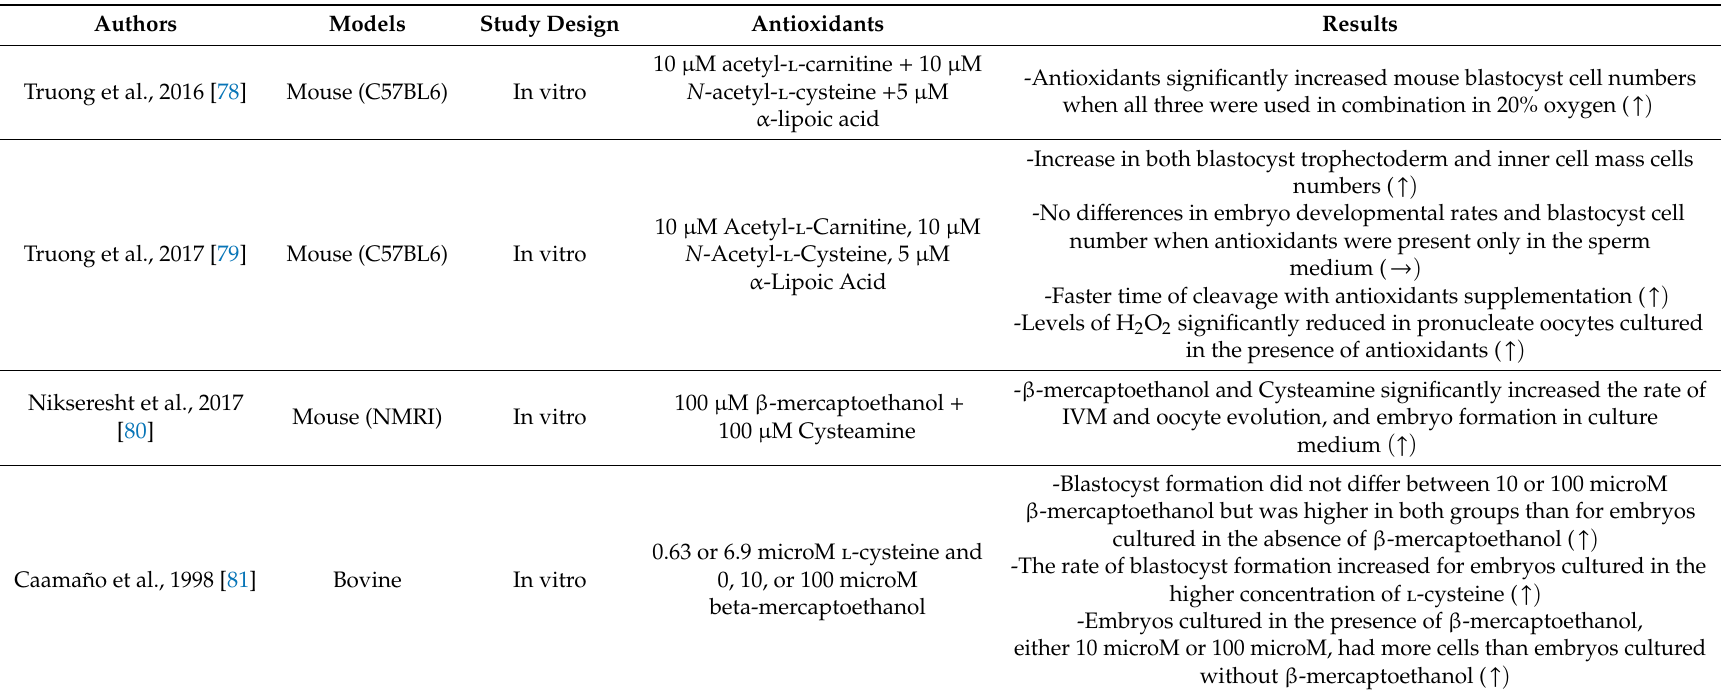
Table 3. Experimental in vitro studies about antioxidants in